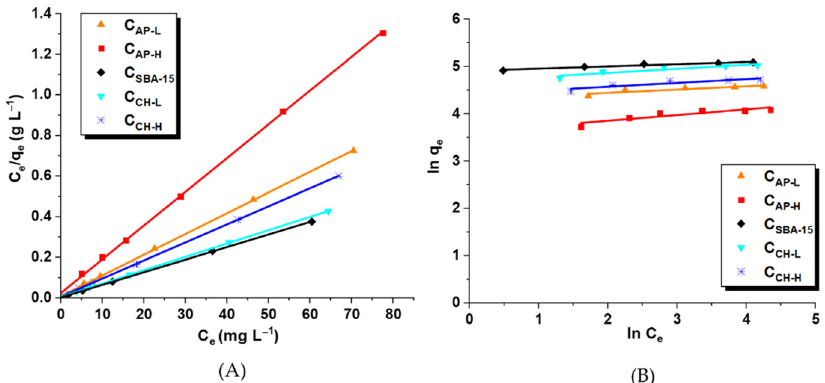
Figure 8. The fitting of experimental data of adsorption of losartan potassium on the surface of C AP-L ,